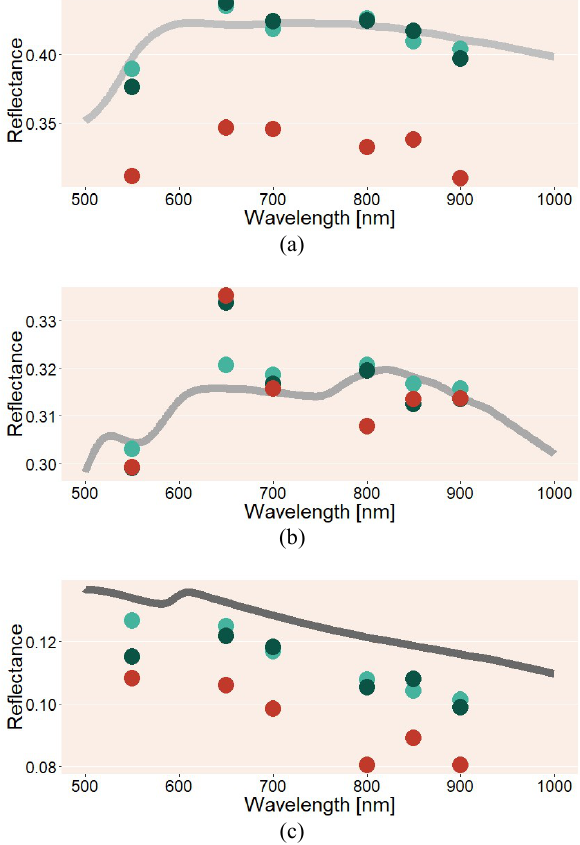
Figure 4. The comparison of three validation target reflectance curves: (a) Pearl 4; (b) Light Grey 5; (c) Medium Grey 7 derived from a spectrometer measurement with median reflectance values of the same targets extracted from raw (red dots), laboratory corrected (green dots) and in-situ corrected image (dark green